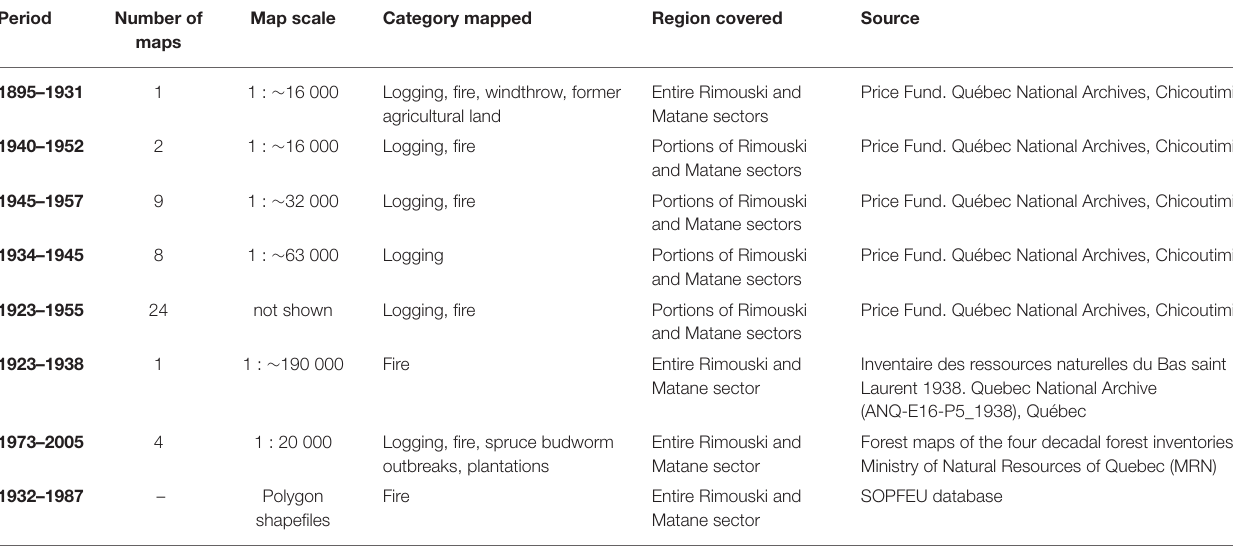
TABLE 1 | Historical maps of disturbance polygons in the study area.